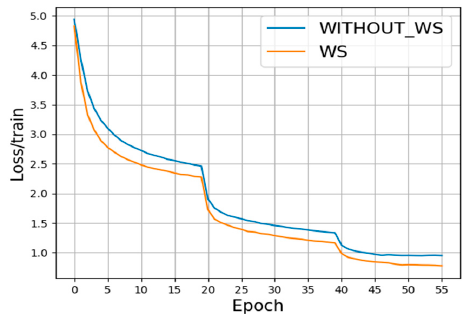
Figure 8. The values of loss over iteration during training process. 4.5. Confusion Matrix of the Proposed Method Confusion matrix is a standard format for accuracy evaluation. Figure 9 shows the confusion matrices created by MEST on Jester.